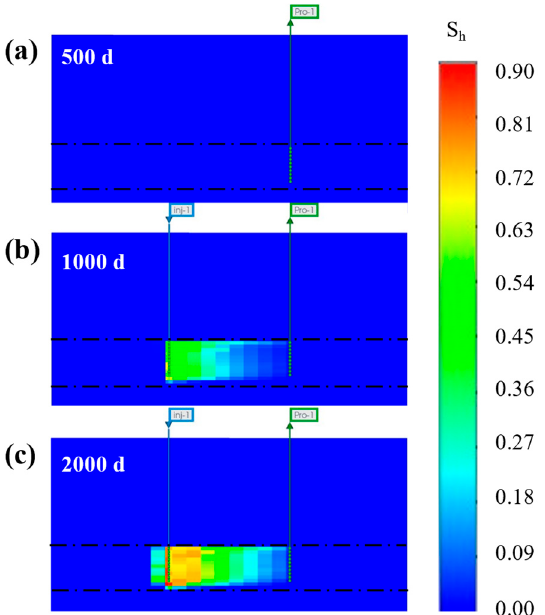
Figure 8. Evolution of CO 2 hydrate saturation after 500 days ( a ), 1000 days ( b ), 2000 days ( c ).